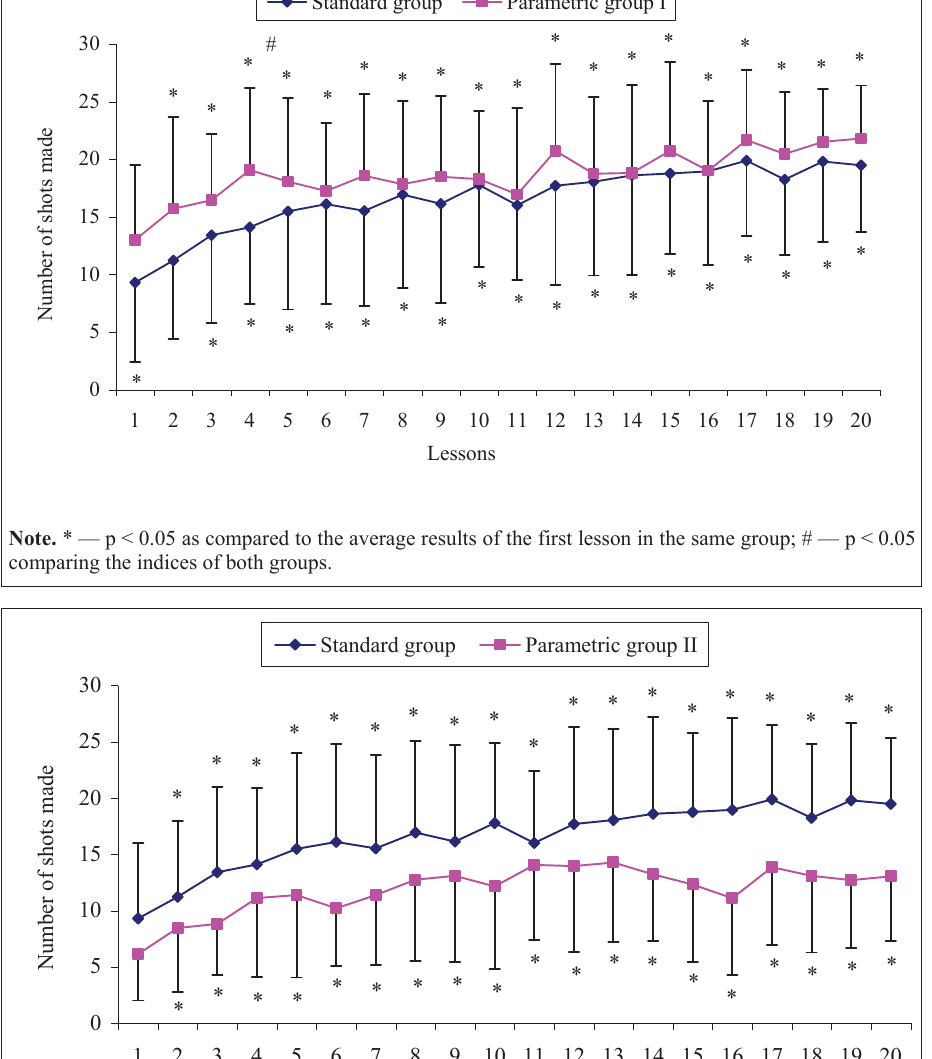
Fig. 4. The indices of the development of